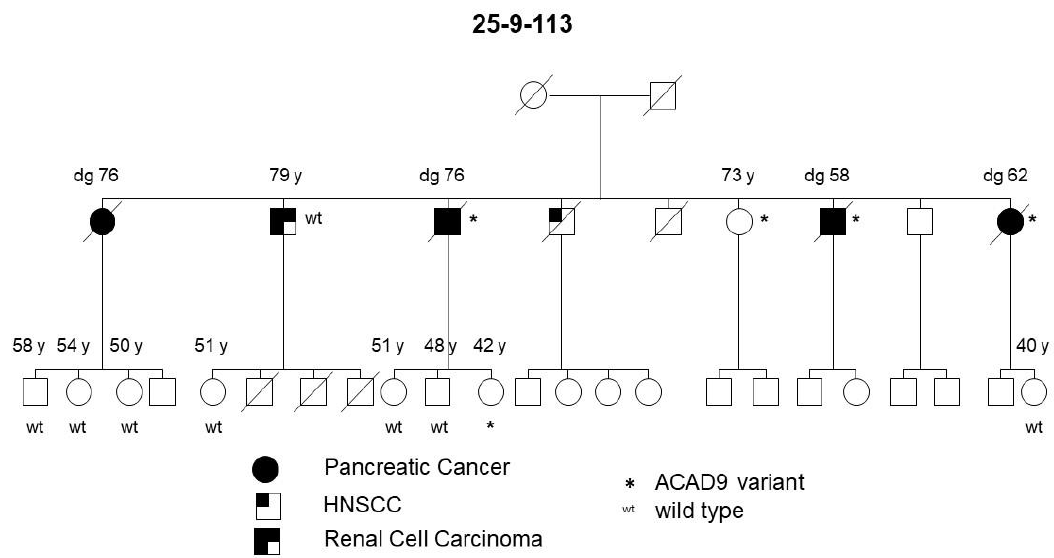
Figure 5. FPC family with a germline ACAD9 A326T variant. Diagonal lines indicate deceased individuals.